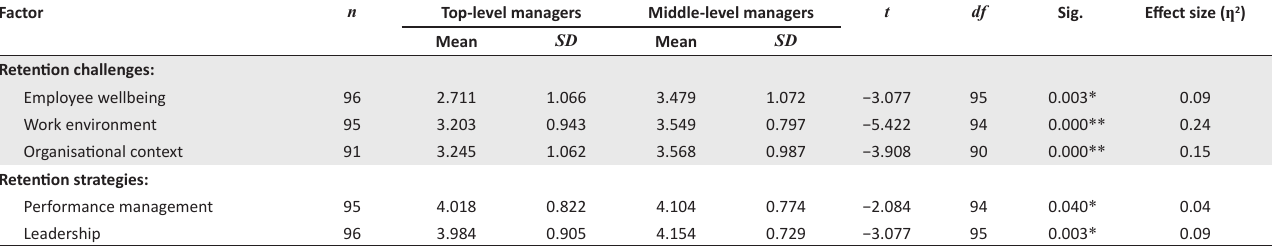
TABLE 3: Differences in the retention strategies and challenges between top- and middle-level managers. Factor